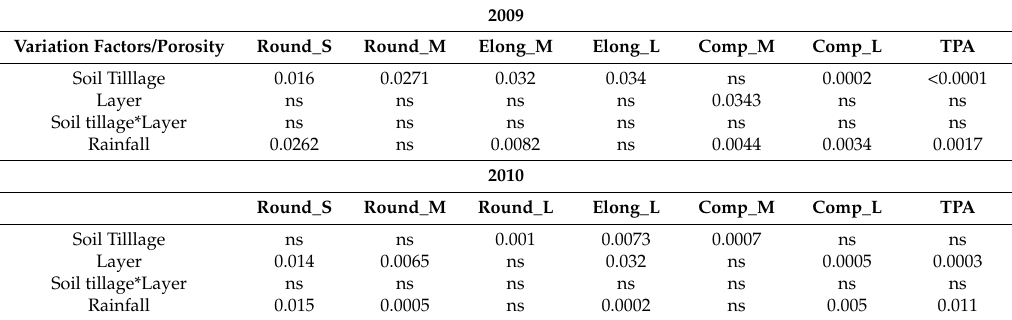
Table 2. Analysis of variance for percentage of pore area in the two years of the experiment and for the studied soil.